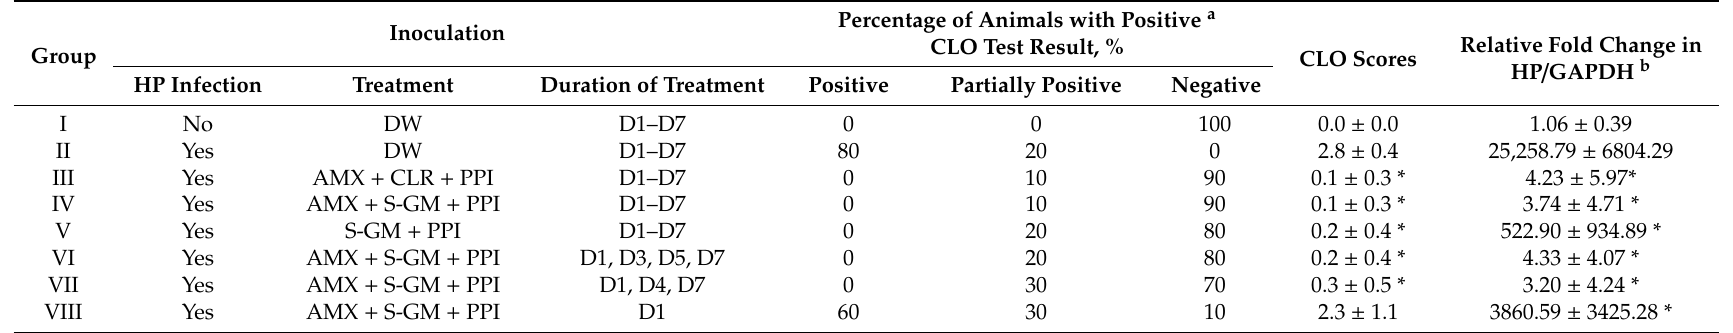
Table 1. Individual data of the CLO test and quantitative PCR of mouse gastric mucosa after treatment of H. pylori infection.